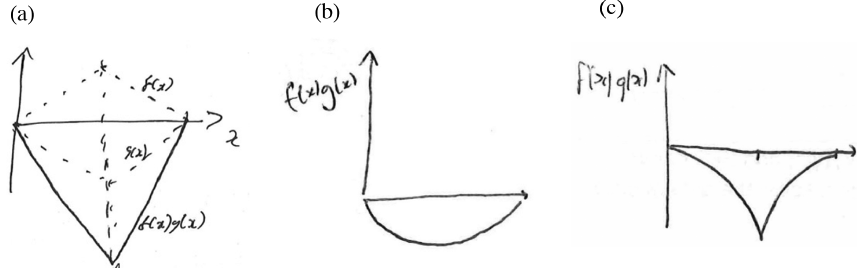
FIG. 8. The three types of sketches made in response to task F of the perturbation theory activity (see Fig. 4). Graph (c) is fully correct, but all graphs contain productive elements, including that they are negative and have a maximum in the middle of the